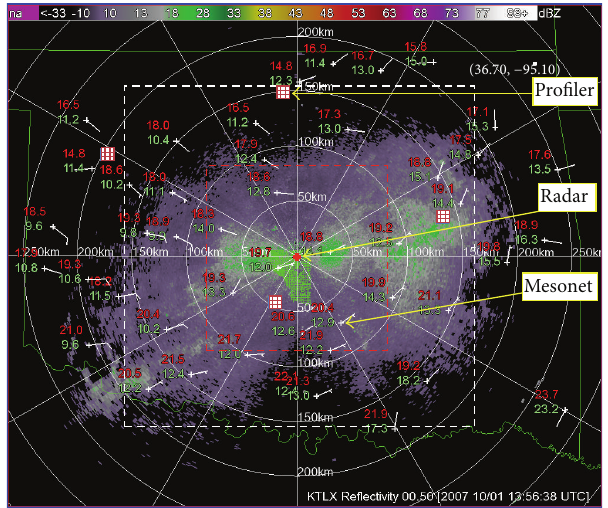
Figure 2: Locations of KTXL radar, wind profilers, and Mesonet stations. The red dashed boundary shows the analysis domains, and the white dashed boundary shows the data